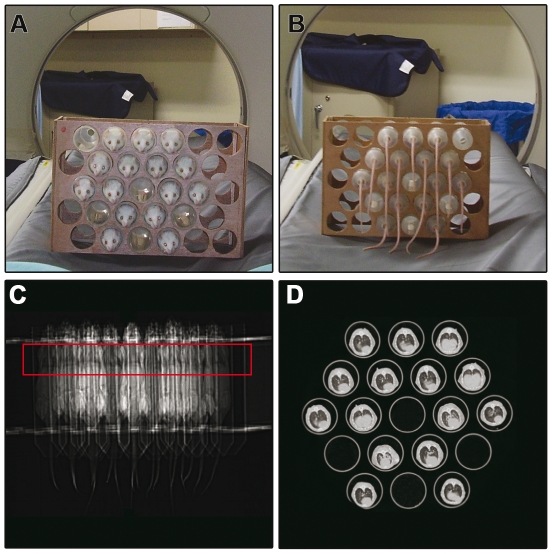
Arrangement of multiple mice for high resolution CT of lungs using a clinical CT-scanner.(A) Animal wood box holder with multiple anesthetized mice placed in prone position inside polypropylene tubes (anterior view). (B) Posterior view of the same structure. (C) Scout view or scanogram to plot the chest area where slice images are obtained (area labeled in red). (D) Panoramic view of multiple lungs in the same axial tomographic section.